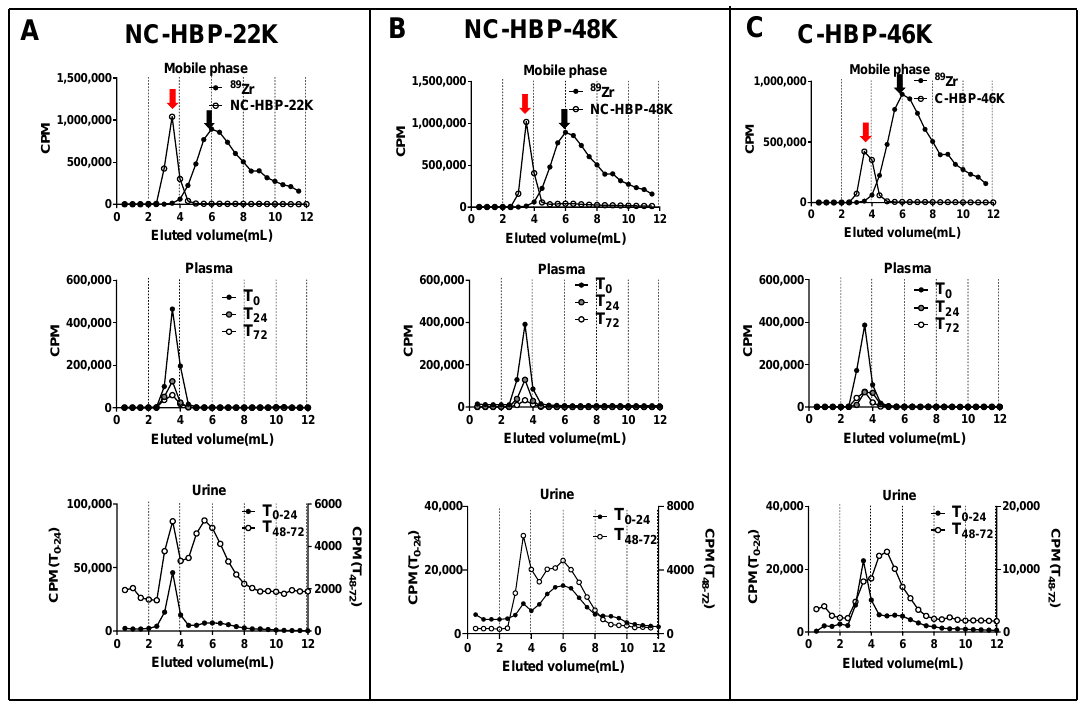
Figure 4. Size exclusion chromatography profiles of plasma and urine obtained from rats dosed intravenously with NC-HBP-22K, NC-HBP-48K, and C-HBP-46K. ( A ) Chromatogram of 89 Zr (peak represented by black arrow) and NC-HBP-22K (peak represented by a red arrow) in mobile phase (top row), plasma (T 0 , T 24 and T 72 h) (middle row) and urine collected over time 0–24 h (T 0–24 ) and 48–72 h (T 48–72 ) (bottom row). ( B ) Chromatogram of 89 Zr (peak represented by a black arrow) and NC-HBP-48K (peak represented by a red arrow) in a mobile phase (top row), plasma (T 0 , T 24 and T 72 h) (middle row) and urine collected over time 0–24 h (T 0–24 ) and 48–72 h (T 48–72 ) (bottom row). Panel ( C ) Chromatogram of 89 Zr (peak represented by black arrow) and C-HBP-46K (peak represented by a red arrow) in a mobile phase (top row), plasma (T 0 , T 24 and T 72 h) (middle row) and urine collected over time 0–24 h (T 0–24 ) and 48–72 h (T 48–72 ) (bottom row). Both plasma and urine samples were pooled from all rats in the group for SEC and radioactivity measurements.